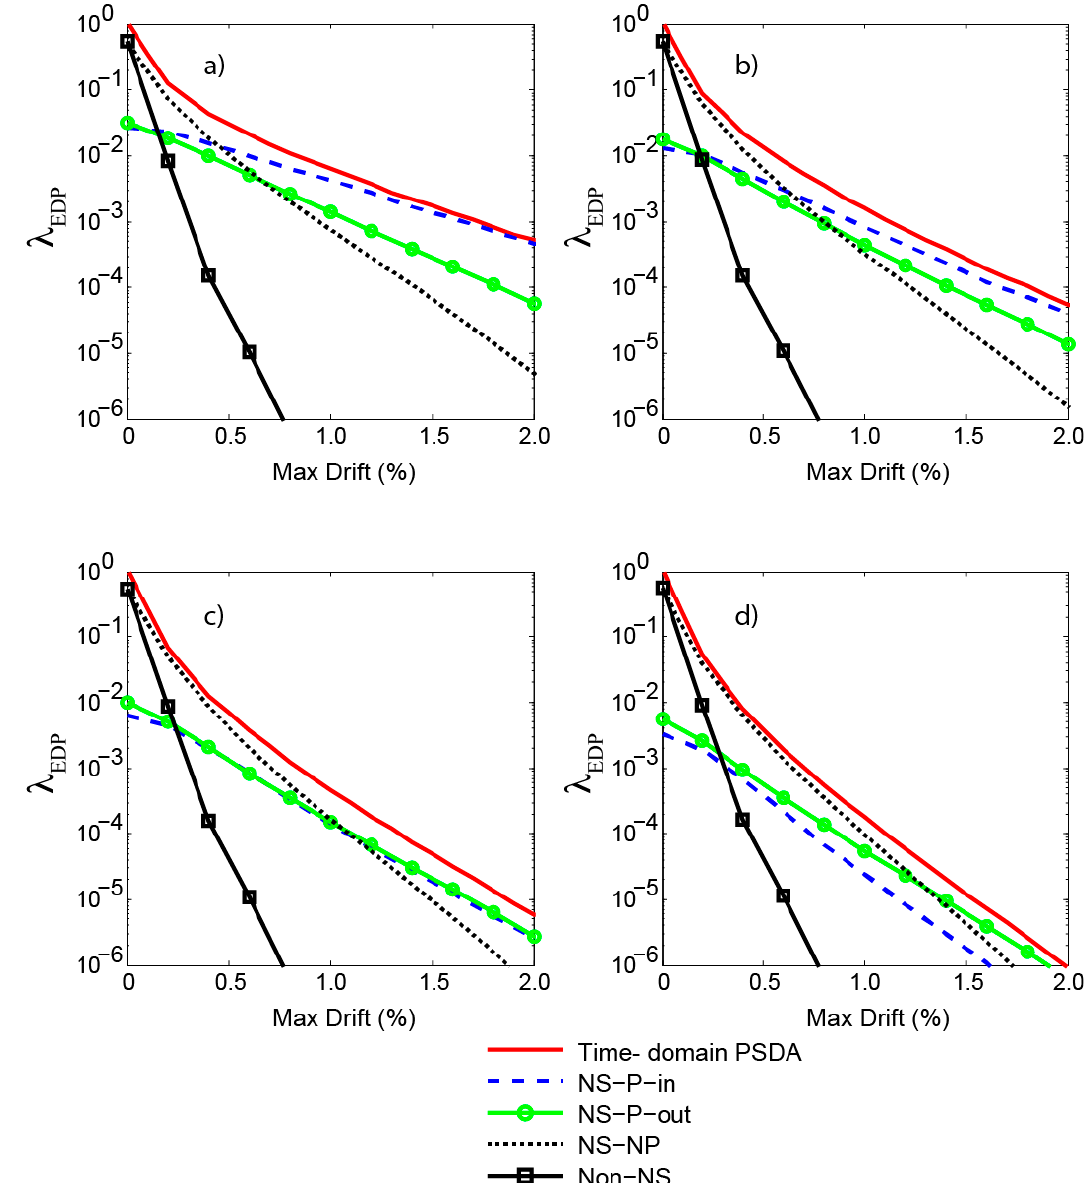
Figure 13. Rate of exceedance of drift vs. maximum drifts from the time-domain probabilistic seismic demand analysis (PSDA), and contributions from different components of the time-domain procedure are shown for sites located at a distance of ( a ) 6 m, ( b ) 11 km, ( c ) 16 km, and ( d ) 21 km from the fault. The labels for the components are: NS-P-in—Near-source pulse motions with pulses dominant; NS-P-out— near-source pulse motions with non-dominant pulses; NS-NP— near-source motions without pulses; and Non-NS—non-near source motions.